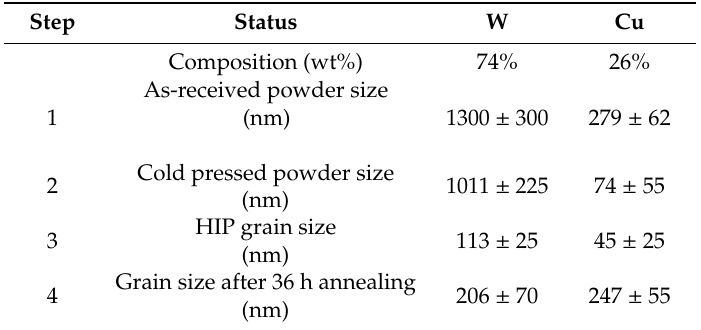
Table 2. X-ray di ff raction (XRD) results of the cW-Cu: cold-pressed sample, hot isostatic pressed specimens, average aged (36 h).